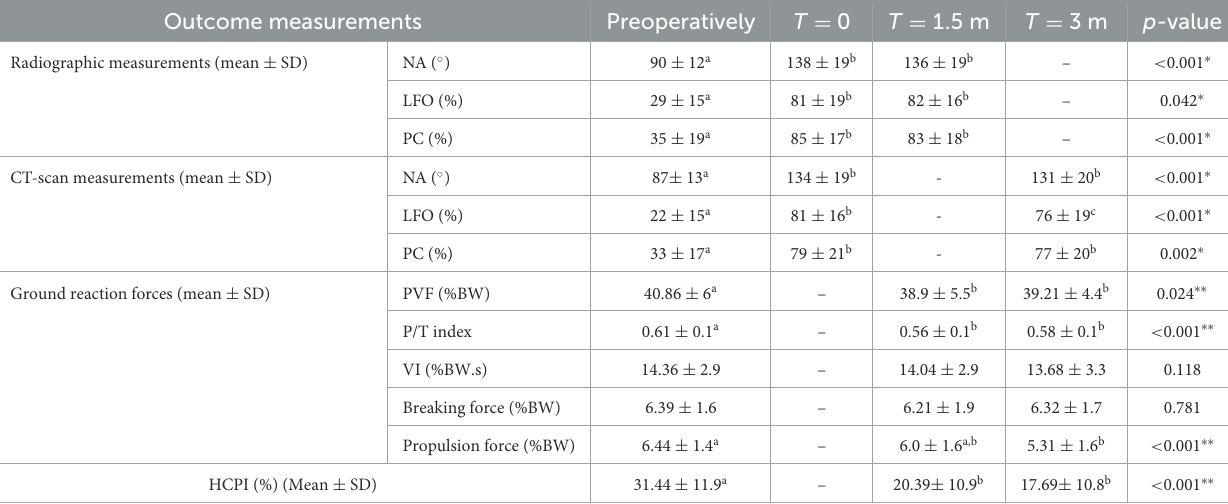
TABLE 2 Results in dogs with hip dysplasia that underwent acetabular rim extension with a titanium shelf implant as measured preoperatively (at inclusion), postoperatively (T = 0), at 1.5 months (T = 1.5m), and at 3 months (T = 3m)